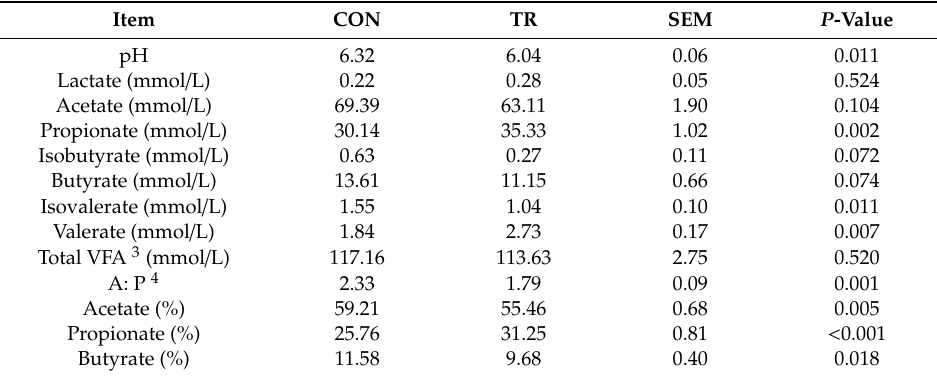
Table 2. Ruminal fermentation parameters of CON 1 and TR 2 groups.